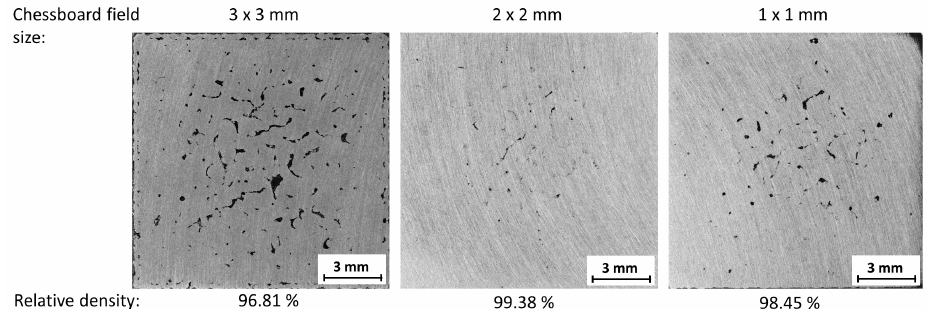
Figure 9. Influence of chessboard field size on the relative porosity.